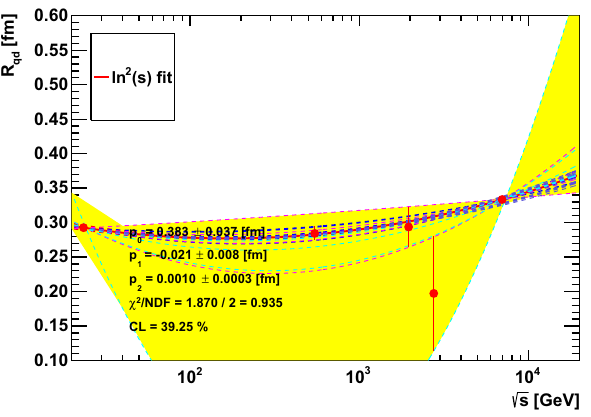
Fig. 23 Systematic error band on the R qd ( s ) parameter as obtained by systematically shifting and fixing the best R qd values up and down by one standard deviation ateachenergy where they are determined( 7 . 0,2 . 76,1 . 96,0 . 546TeVand23 . 5GeV)andthenre-fittingalltheother parameters to account for the correlations between the parameters of the ReBB model. The central line indicates the best estimate for the quadratic in ln ( s ) polynomial for R qd ( s )